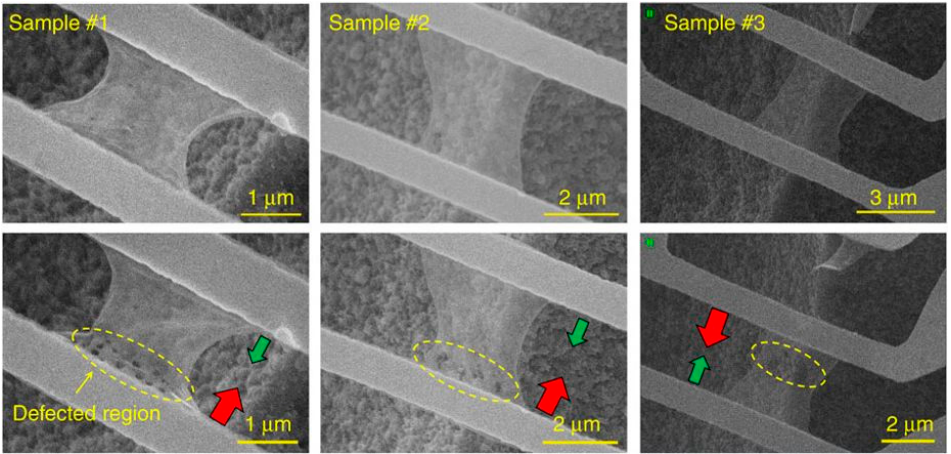
Figure 5. SEM images of graphene Samples 1, 2, and 3 before and after nanopores drilled by using a focused ion beam. Reprinted with permission from Springer Nature Publishing Group.